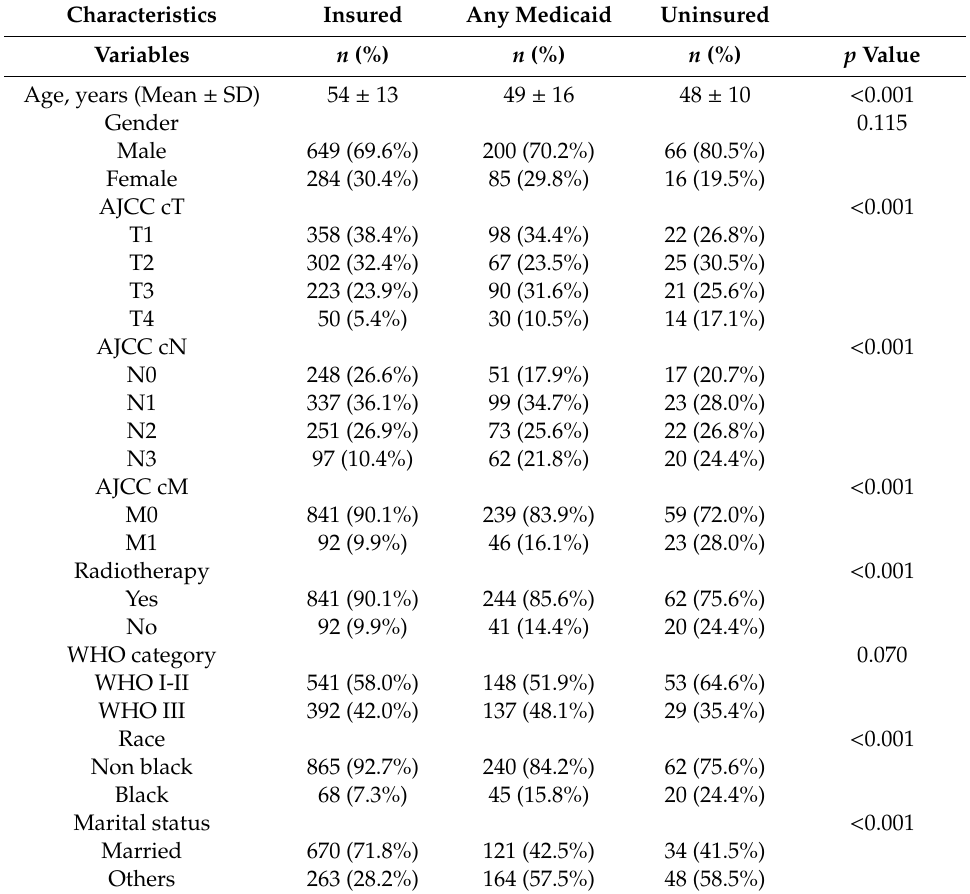
Table 1. Baseline characteristics of nasopharyngeal cancer patients according to insurance status, n =